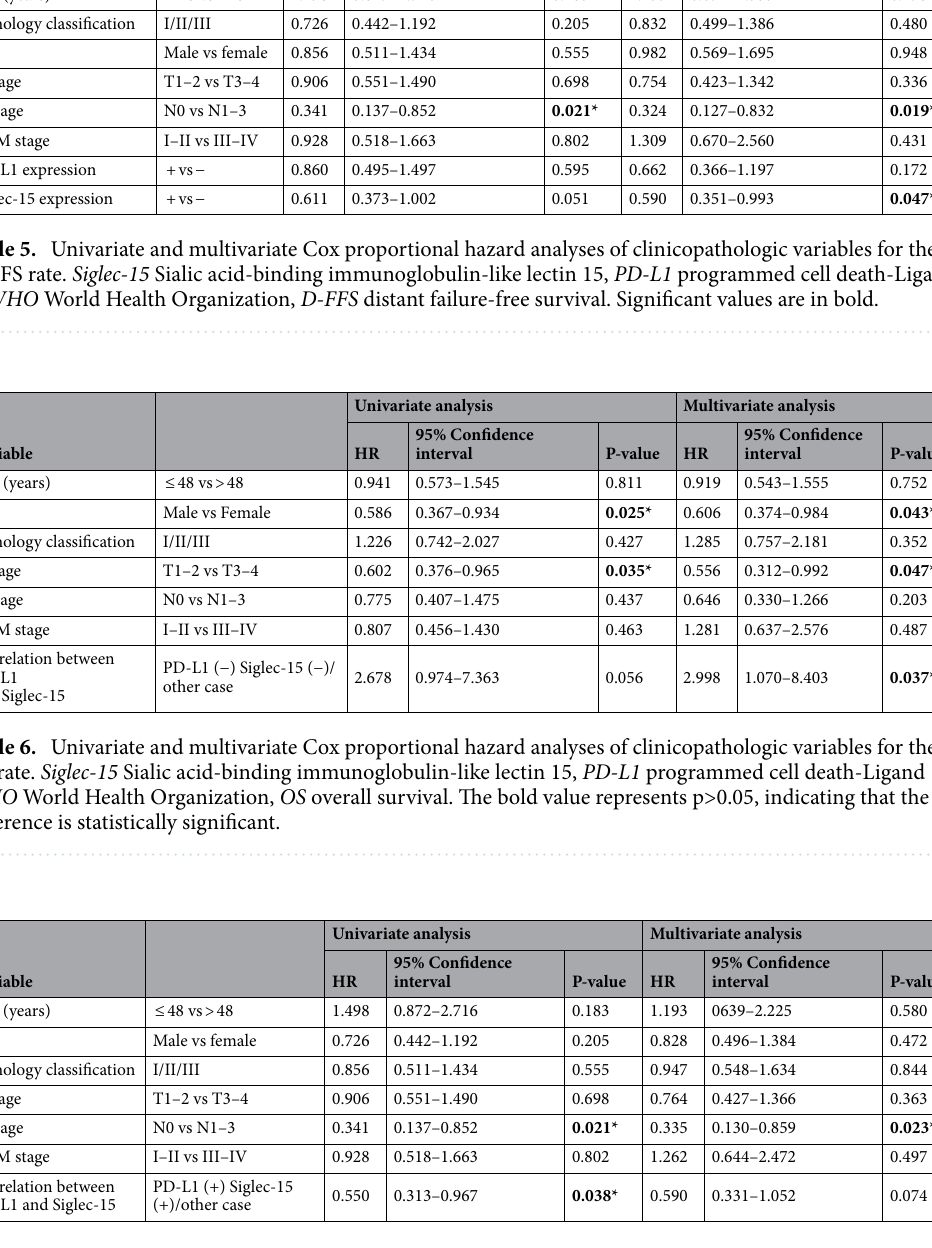
Table 7. Univariate and multivariate Cox proportional hazard analyses of clinicopathologic variables for the D-FFS rate. Siglec-15 Sialic acid-binding immunoglobulin-like lectin 15, PD-L1 programmed cell death-Ligand 1, WHO World Health Organization, D-FFS distant failure-free survival. The bold value represents p>0.05, indicating that the difference is statistically significant.